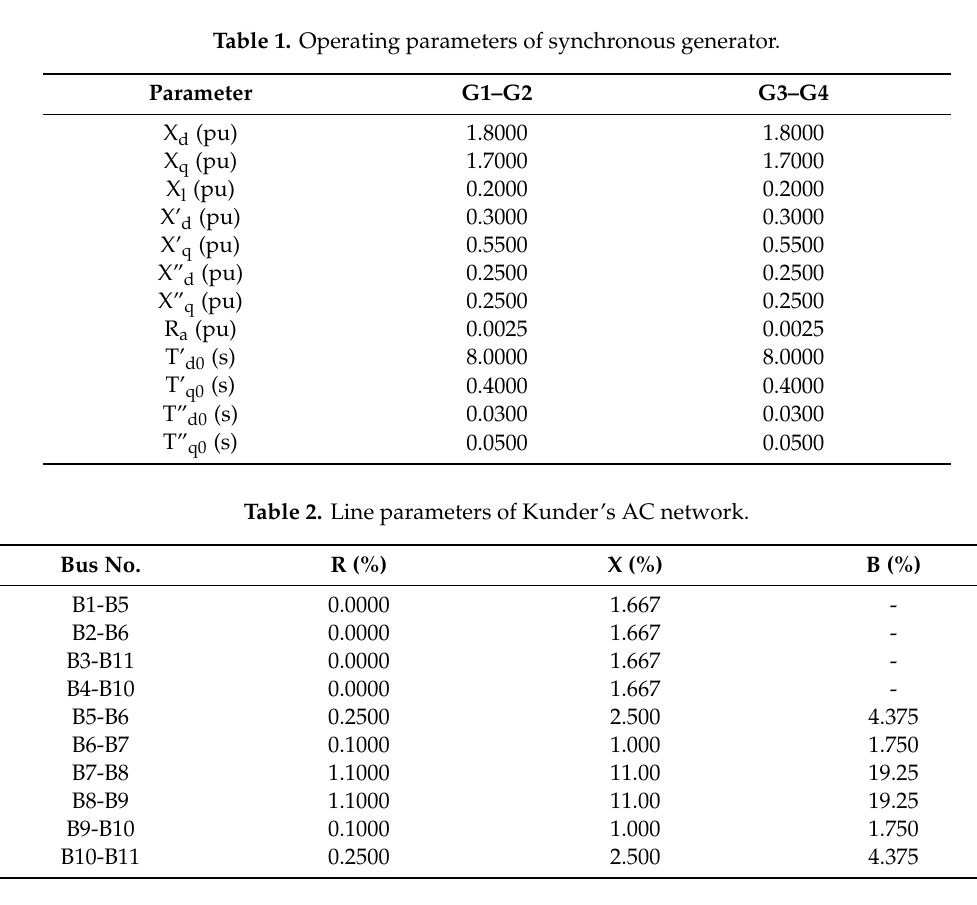
Table 3. Load and shunt capacitance connected in Kunder’s AC network.